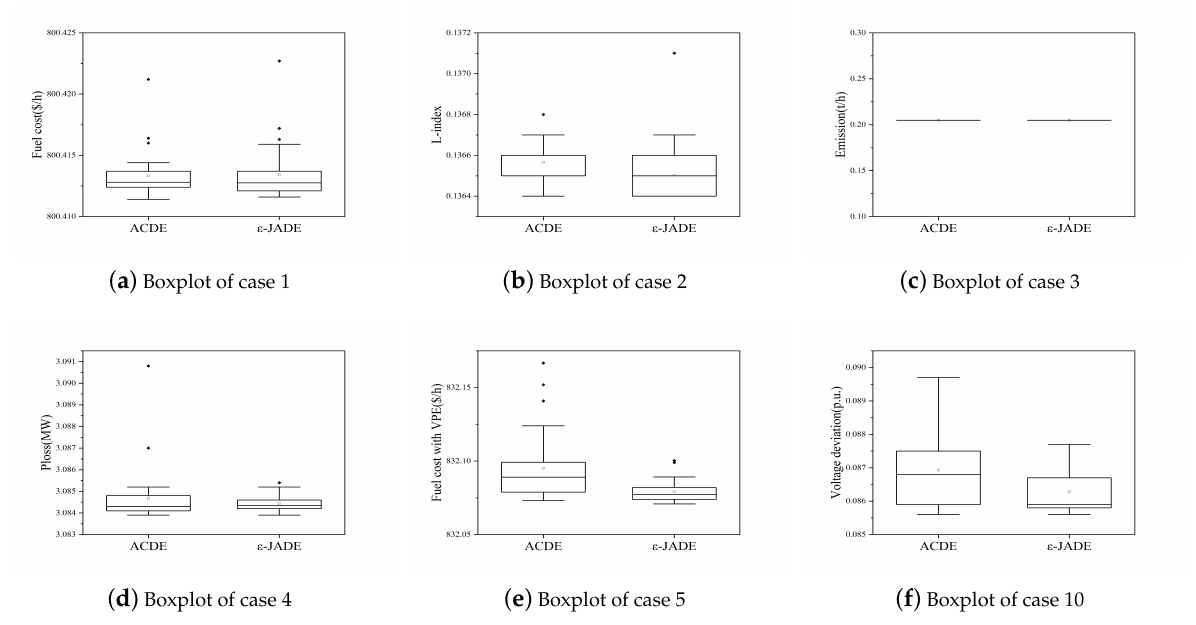
Figure 1. Comparison of I (cid:101) JADE and ACDE.